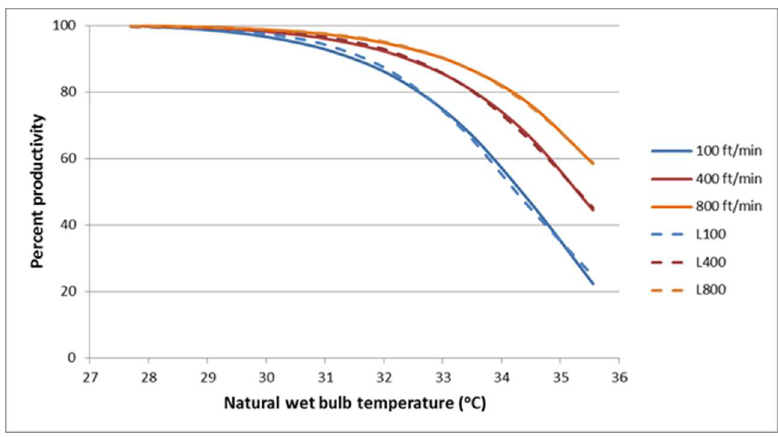
Figure 1. The Wyndham’s exponential model (solid lines) and our logistic curves (dashed lines). The estimated logistic curves, shown as dashed lines in Figure 1,